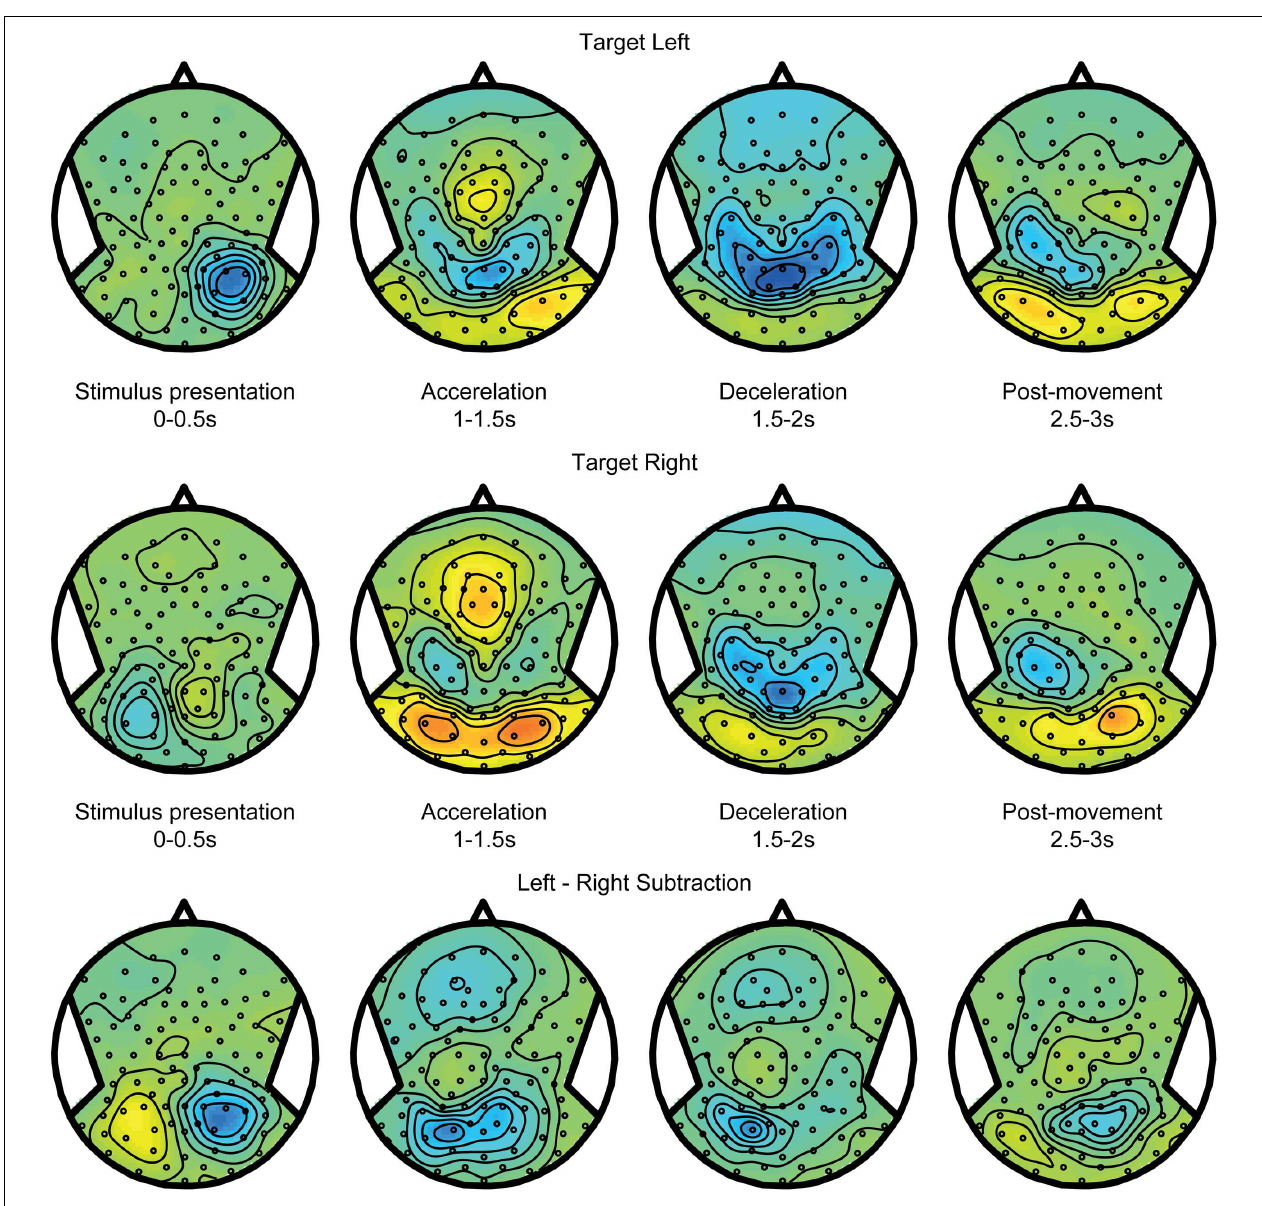
FIGURE 6 | Spatial updating across hemifields. Same as Figure 5 , but averaged over trials where the target is updated across hemifields, and is thus perceived to cross fixation. Consequently, the remembered target representation can be seen to remap to the other hemisphere after